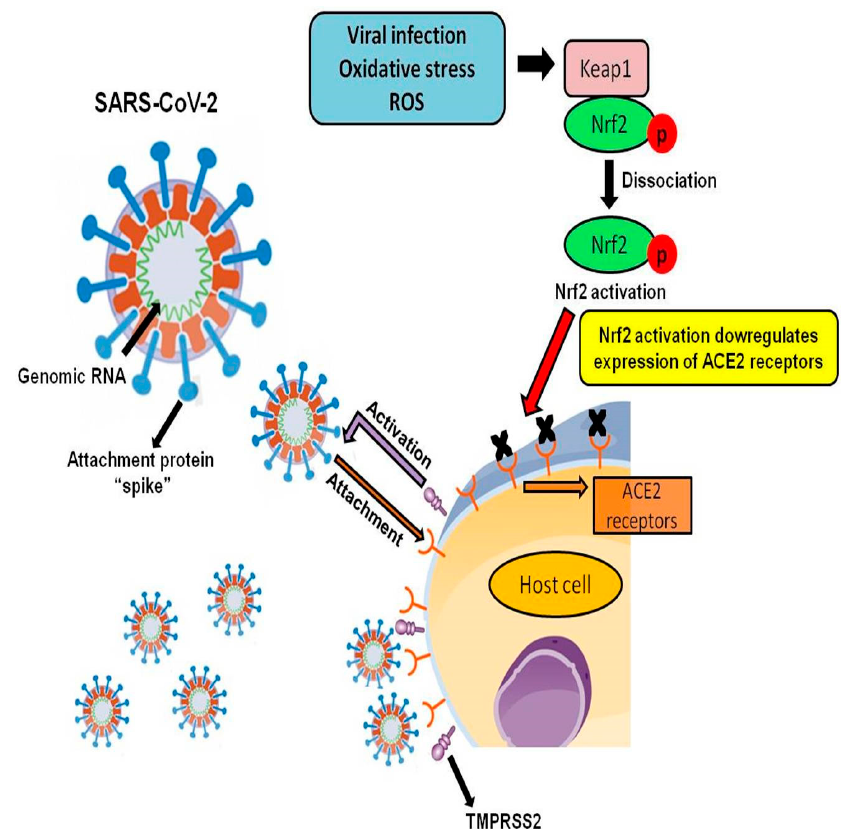
Figure 2. Nrf2 downregulatory effect on ACE2 Receptors during severe acute respiratory syndrome coronavirus 2 (SARS-CoV-2 infection). The diagram illustrates SARS-CoV-2 binding to its ACE2 receptors in the host cell through its attachment protein “spike” and concomitant TMPRSS2 activation, initiating the infection process. The figure also presents Nrf2 activation and subsequent decrease in ACE2 receptor expression, as described by Zhao et al., 2018 [62] .